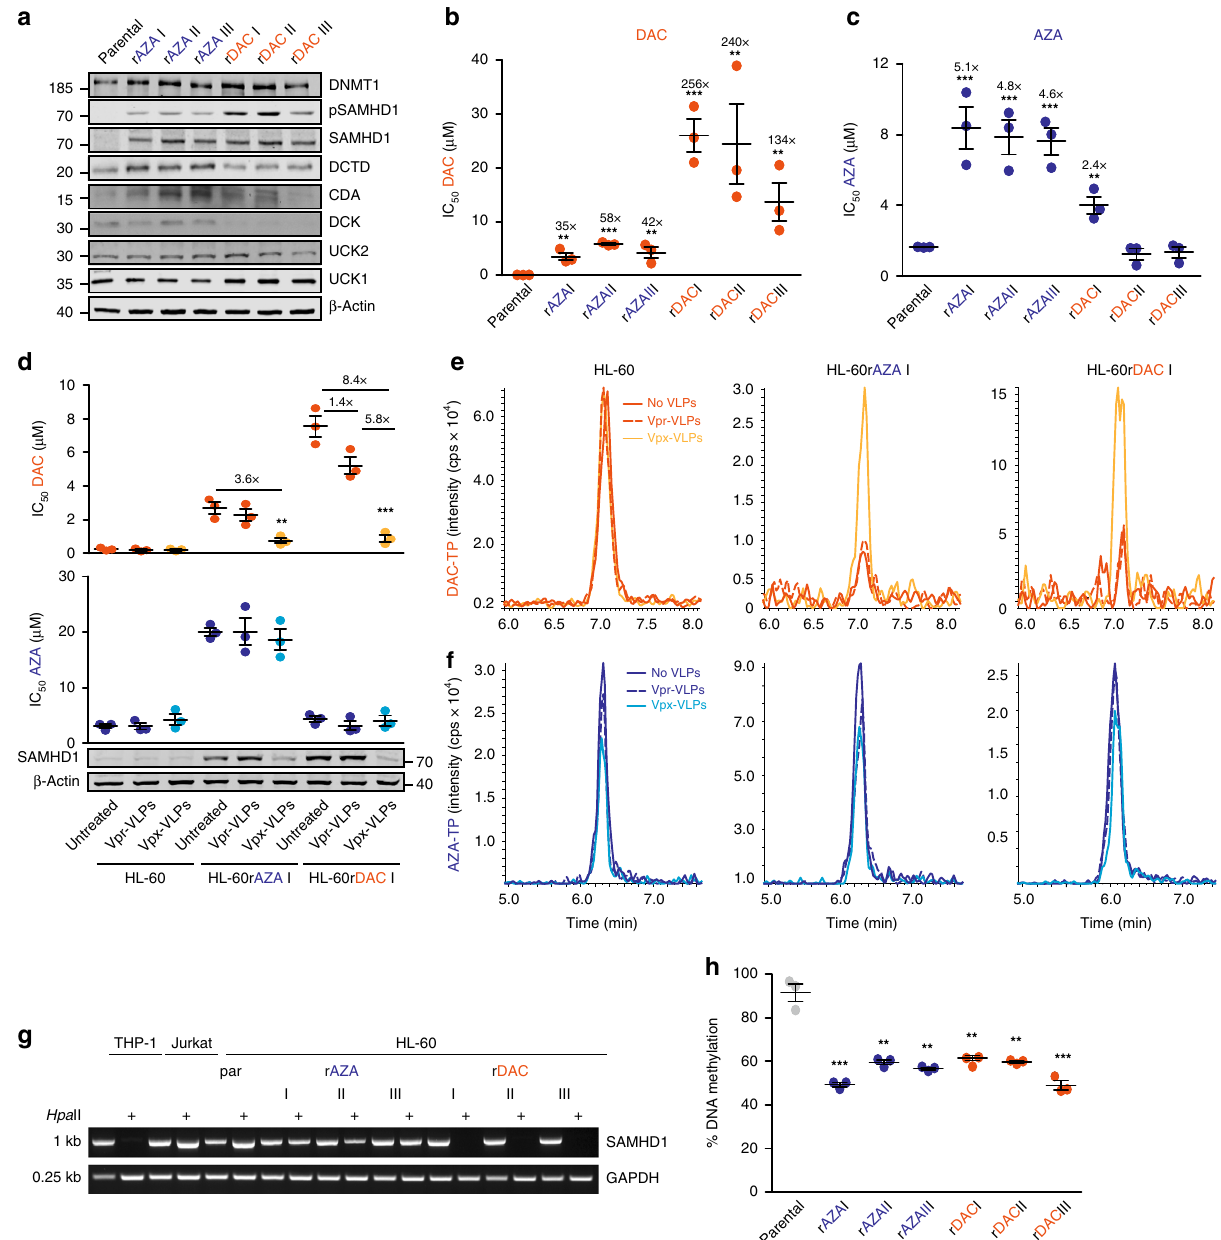
Fig. 4 HMA resistance development in HL-60 cells results in SAMHD1 upregulation. a Representative immunoblots of SAMHD1, other proteins involved in AZA and DAC metabolism, and DNA methylation (DNMT1) in parental HL-60 cells and in three AZA- or DAC-resistant HL-60 sublines (rAZA I – III, rDAC I – III). β -Actin served as a loading control. b , c IC 50 values for ( b ) DAC and ( c ) AZA in AZA- and DAC-resistant cell lines relative to the parental counterpart. Each circle represents a technical replicate ( n = 3) of three independent experiments performed. Horizontal lines and error bars represent means ± s.d. The numbers above the data points indicate the factor of increase of IC 50 values in resistant cells relative to parental HL-60 cells. d Parental, AZA- and DAC-resistant HL-60 cells were treated with the VLPs indicated and subsequently analyzed for AZA and DAC cytotoxicity (top) and SAMHD1 expression (bottom). IC 50 values of three independent experiments each performed with technical replicates ( n = 3) are presented as closed circles. Horizontal lines and error bars represent means± s.d. Numbers above the bars indicate the factor of decrease in IC 50 values in Vpx-VLP-treated cells relative to Vpr-VLP-treated controls. e , f Representative LC – MS/MS analyses of ( e ) DAC-TP and ( f ) AZA-TP in parental and AZA- or DAC-resistant HL- 60 cells, treated with Vpx-VLPs (yellow/light blue chromatogram), with control Vpr-VLPs (dashed orange and dark blue chromatogram) or left untreated (orange and dark blue chromatogram). g Analysis of SAMHD1 promotor methylation through ampli fi cation of a single PCR product (993-bp) corresponding to the promoter sequence after Hpa II digestion. A 0.25-kb fragment of the GAPDH gene lacking Hpa II sites was PCR-ampli fi ed using the same template DNA served as loading control, THP-1 and Jurkat cells served as positive and negative controls, respectively. h Global DNA methylation determined by measurement methylation levels of long interspersed element (LINE)-1 in parental HL-60 cells and rAZA or rDAC HL-60 sublines. Each circle represents means ± s.d. of a technical replicate ( n = 3) of one representative experiments out of